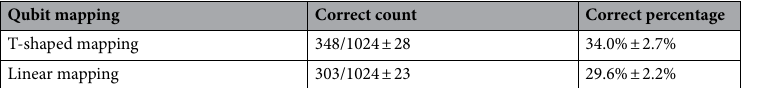
Table 2. The average correct counts and percentages on the real quantum computer ibmq_vigo with two different qubit mapping strategies. The mapping strategy leveraging the advantage of the T-shaped connectivity has better performance than the linear mapping strategy.